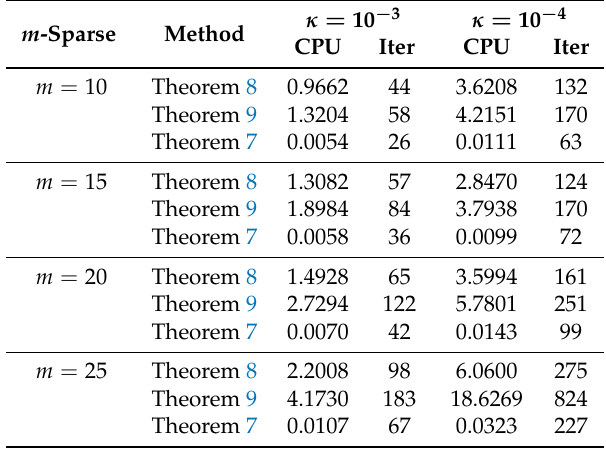
Table 4. Numerical results for the LASSO problem in case M = 2048, N = 1024. m